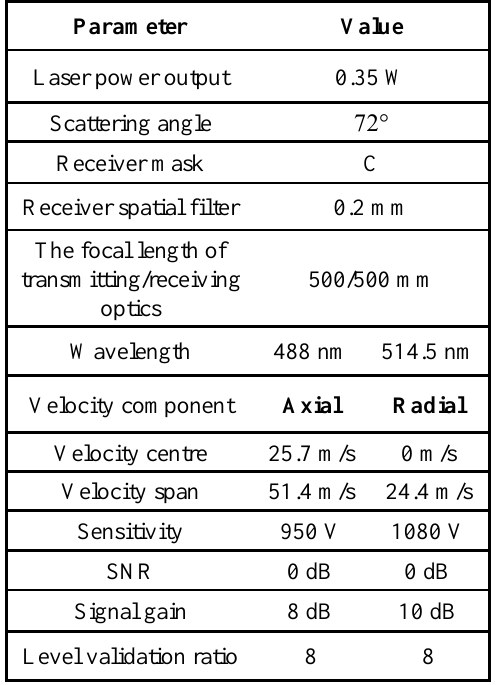
Fig. 6. The main system parameters